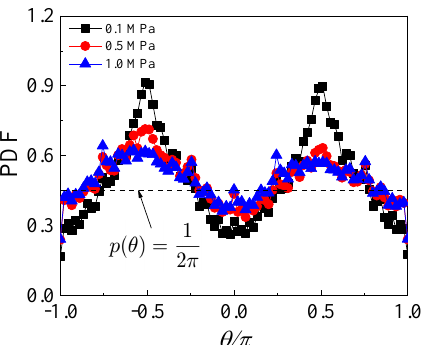
Figure 8. Probability density function (PDF) of angles θ obtained from the flame front, as defined in Figure 3c, under different pressures. The PDF of the isotropic unit normal vector p ( θ ) = 1/ ( 2 π ) is also plotted in the figure.